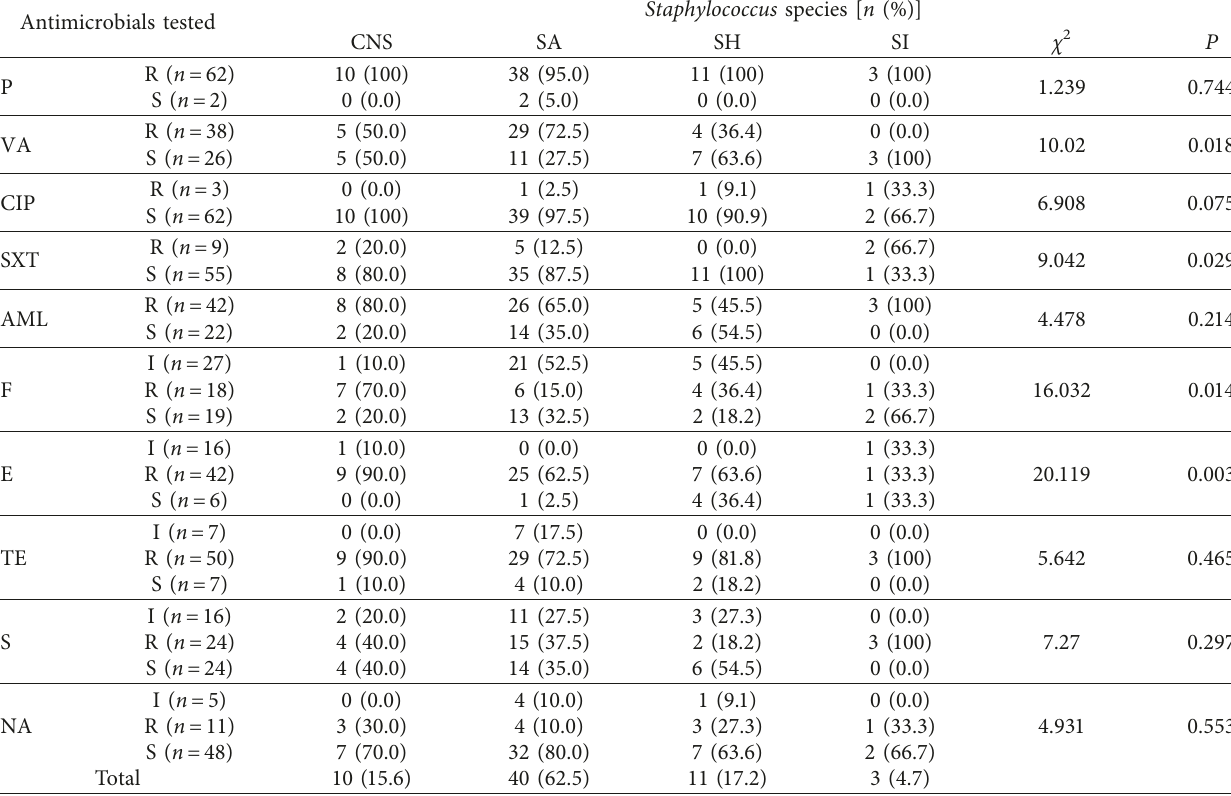
Table 4: Antimicrobial susceptibility patterns of Staphylococcus